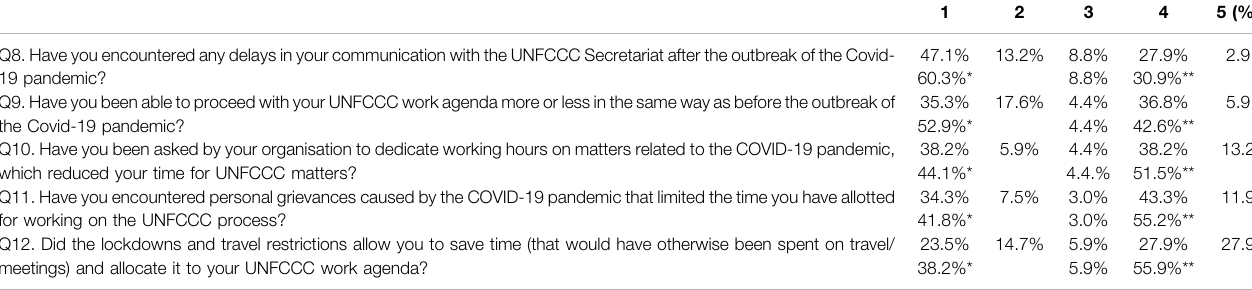
TABLE 1 | Results on questions regarding the in fl uence of the COVID-19 pandemic on the UNFCCC work